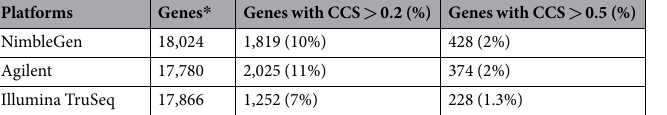
Table 1. Low coverage genes with high CCS scores in three different datasets. * Gene sets in different platforms were defined as described in the Methods